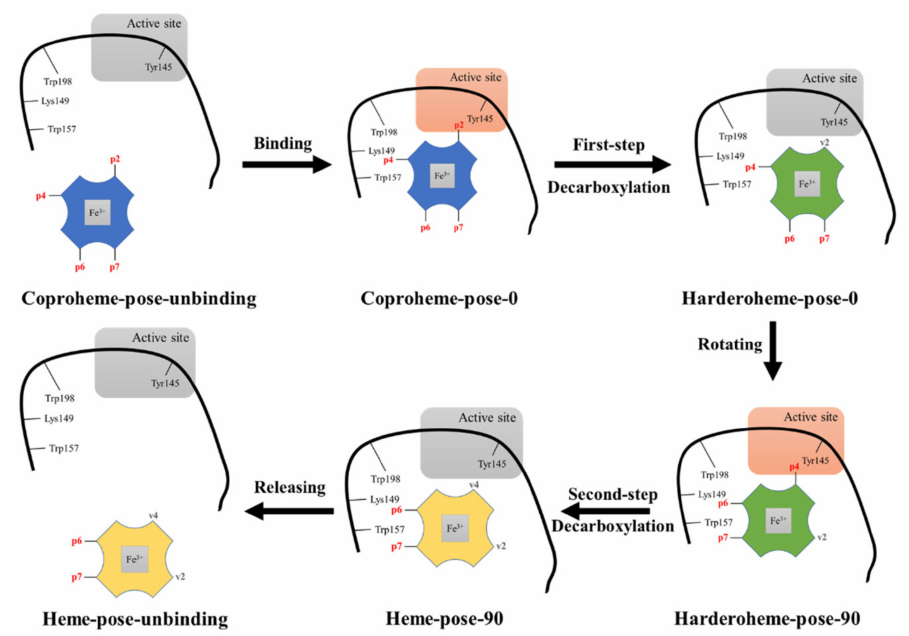
Figure 2. The complete catalytic process of coproheme decarboxylation of GsChdC, highlighting different relevant binding orientations of coproheme (blue), harderoheme (green) and heme b (yellow) in GsChdC with respect to the catalytic decarboxylation site Tyr145. The color of